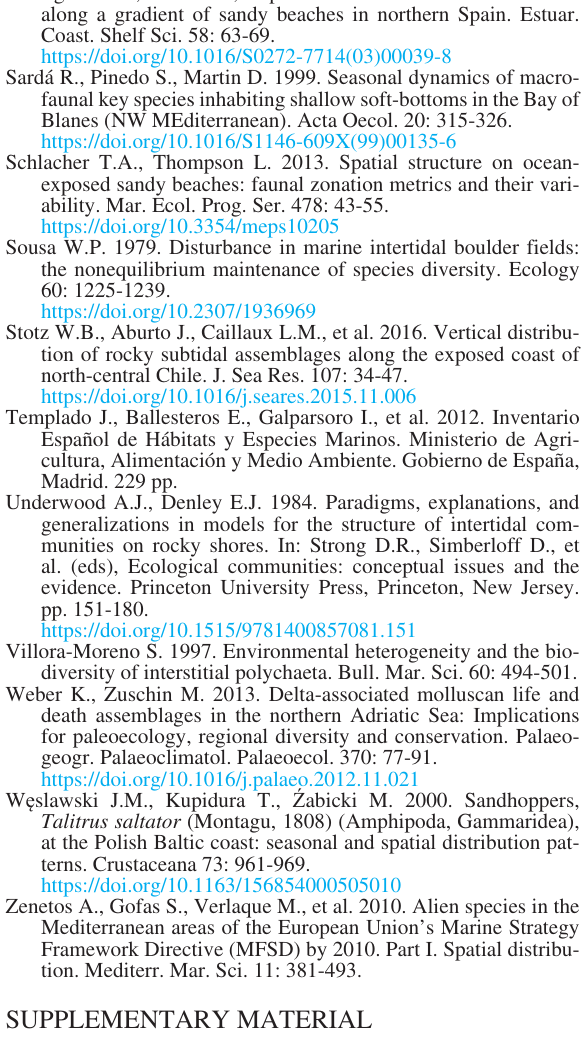
Table S1. – A, total abundance values for grabs and traps (ind. m –2 and ind. h –1 trap –1, respectively); and B, total abundance values for qualitative samples (ind. sample –1